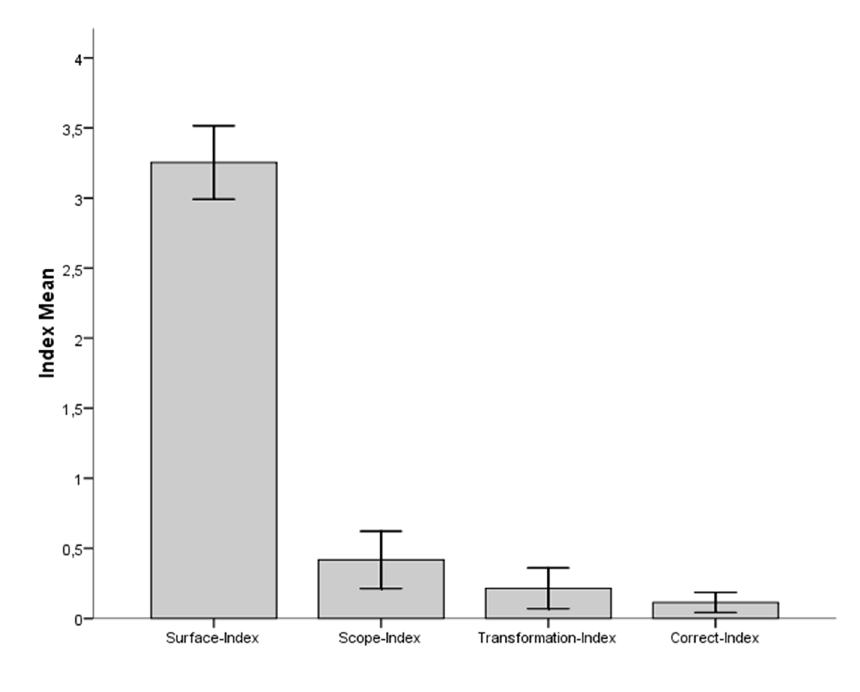
Figure 1. General response pattern for law 1. Error bars represent a 95% confidence interval for the